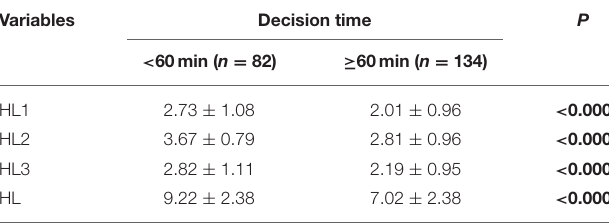
TABLE 2 | Comparison of HL between different decision time.